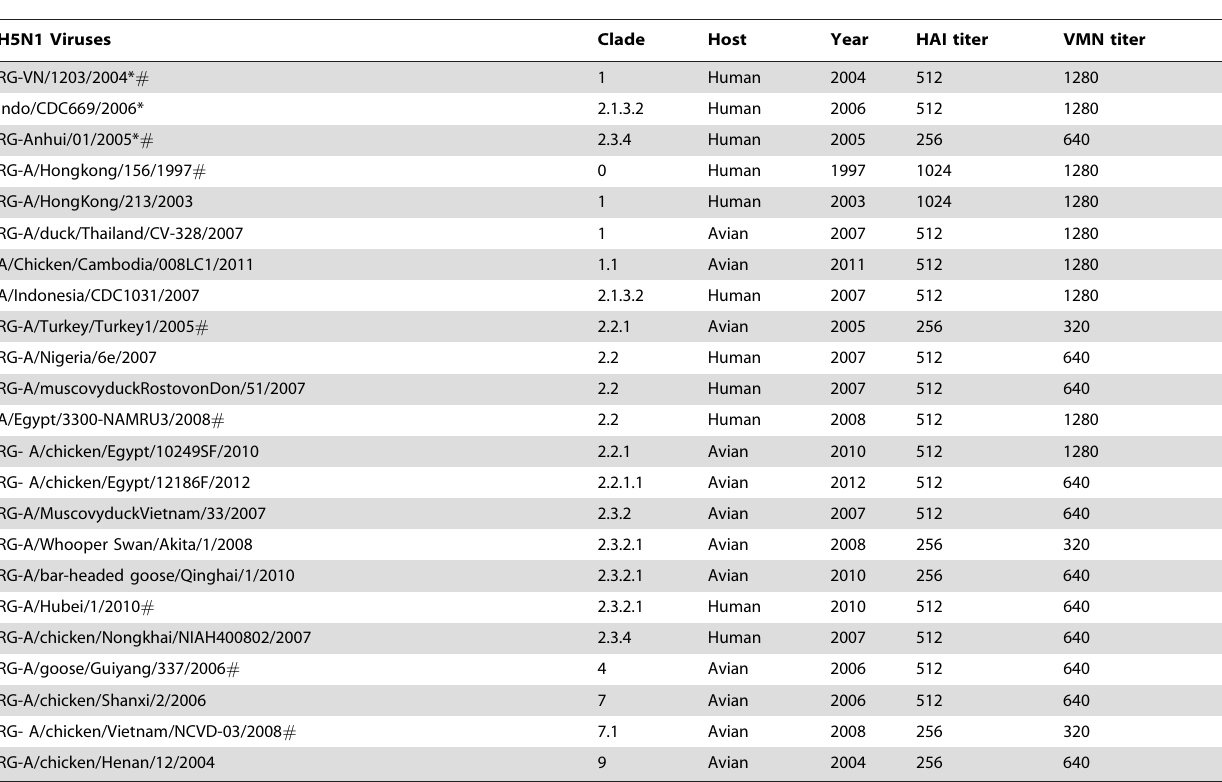
Table 1. Serological surveillance of anti-MVAtor-tri-HA sera against H5N1 strains by HAI and VMN titers.